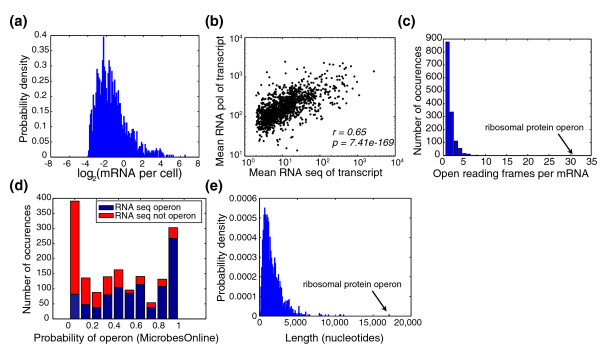
Basic features of the S. elongatus transcriptome. (a) Distribution of absolute transcript abundance per cell. Only transcripts with mean coverage of over two reads per nucleotide (corresponding to approximately 1 mRNA per 15 cells) are shown, and a total of 1,500 mRNA per cell is assumed [8,9] (Materials and methods). (b) RNA sequencing versus RNA pol ChIP. Absolute transcription (RNA sequencing averaged over transcript) and absolute RNA pol occupancy (RNA pol ChIP averaged over transcript) are generally correlated (Pearson correlation, r = 0.65). The probability of getting a correlation as large by random chance (P-value) is 7.41e-169. (c) Distribution of ORFs per mRNA. Most mRNAs contain one to two ORFs. The extreme case is that of an operon composed primarily of ribosomal proteins that includes 31 ORFs and is 17,158 nucleotides in length. (d) Operon estimations based on RNA sequencing versus bioinformatic predictions. Comparison of RNA sequencing based operon determination and bioinformatic predictions from MicrobesOnline [12,13]. (e) Distribution of mRNA lengths. The median mRNA length is 1,320 nucleotides, approximately twice the median size of an ORF (776 nucleotides) in S. elongatus.